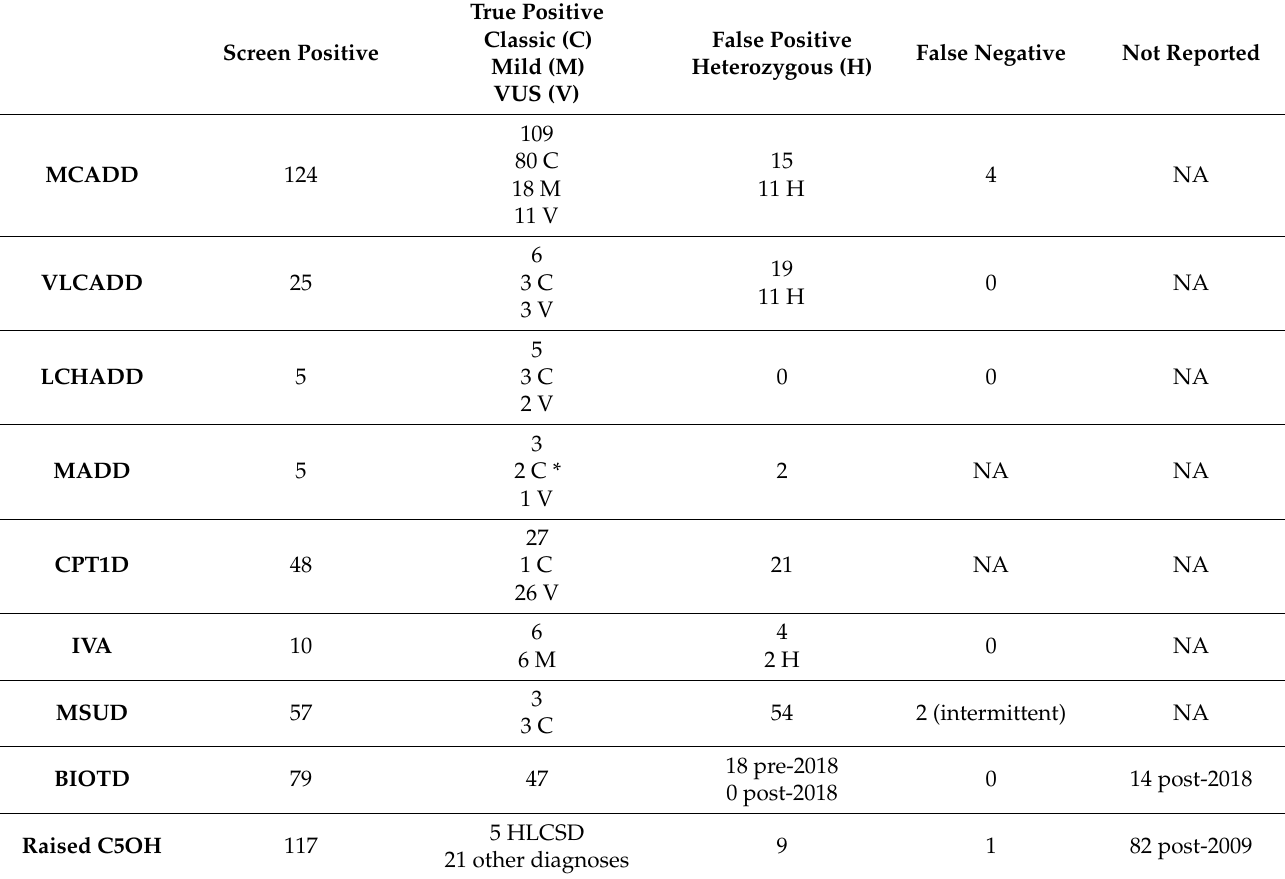
Table 1. Number of children with screen positive, true positive, false positive, false negative and not reported results during eNBS. Classic (C), mild (M), variants of uncertain significance (VUS, V) and heterozygous variants (H) represent the genotypes found during sequencing of the initial filter paper blood spot sample (see also Methods). * This is the clinical phenotype as sequencing was not